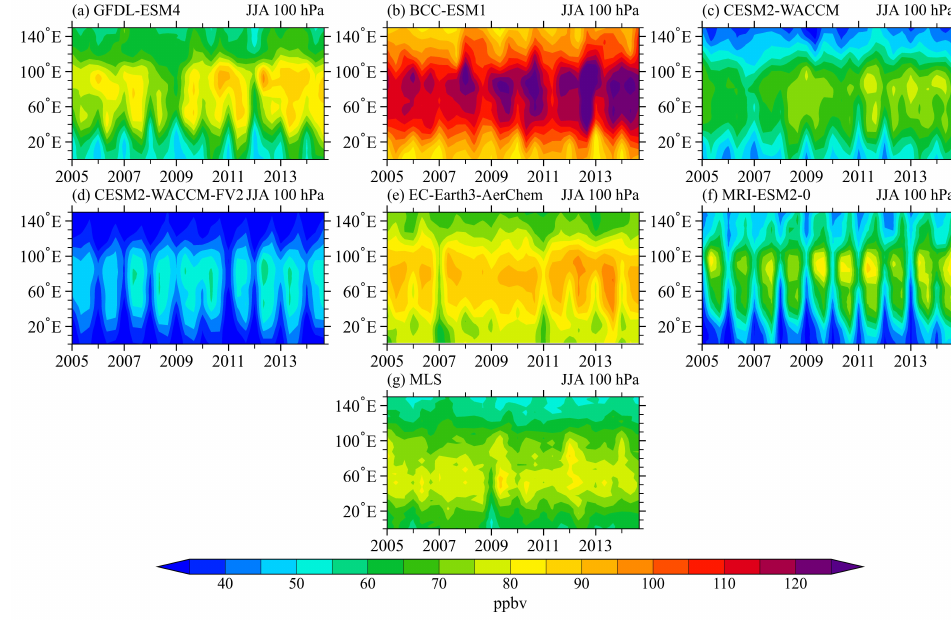
Figure 6. Same as Figure 5, but for CO mixing ratio averaged over 10 ◦ –40 ◦ N.